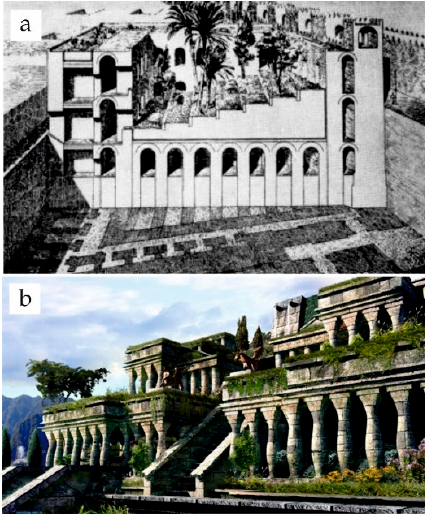
Figure 4. Hanging Gardens of Semiramis (graphic reconstruction); ( a ) https://present5.com/arxitektura-dvurechya-mesopotamiya-1-v-tys-do-n/ (accessed on 8 July 2020); ( b ) http://ancient-buildings.ru/architektura-drevnego-vostoka/gde-nachodilis-visyachie-sadi.html (accessed on 1 June 2022). These were not only a myth but existed in the culture of Mesopotamia [30]. In